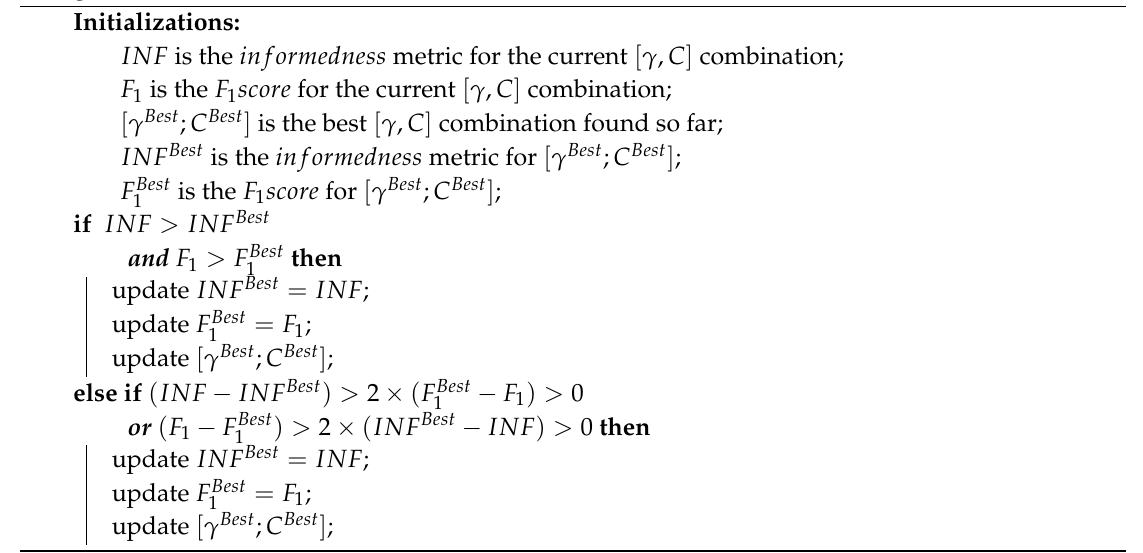
Algorithm 1: Performance metrics criteria.